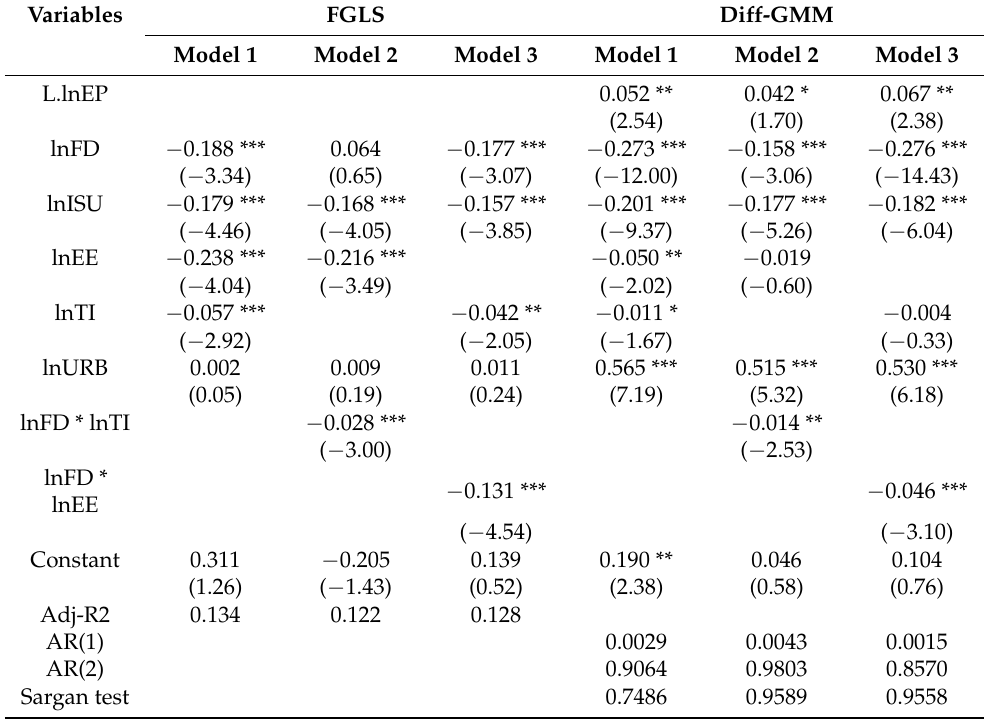
Table 5. Results of the impact of FD on